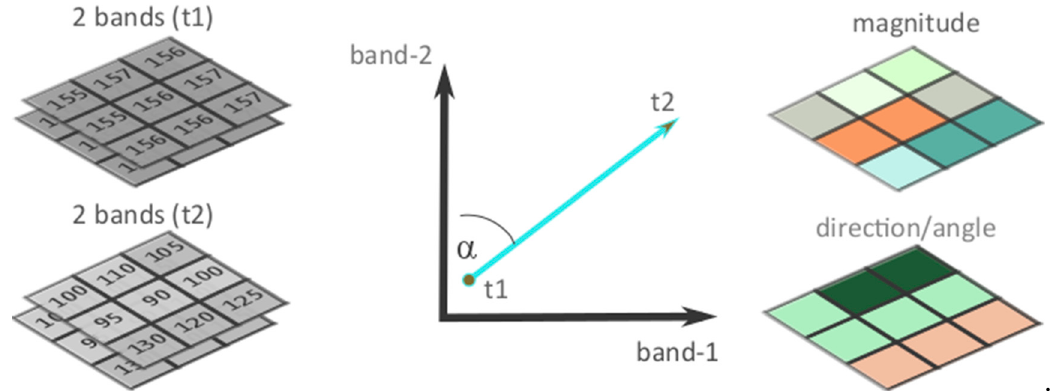
Figure 2. Graphical illustration of change vector analysis.